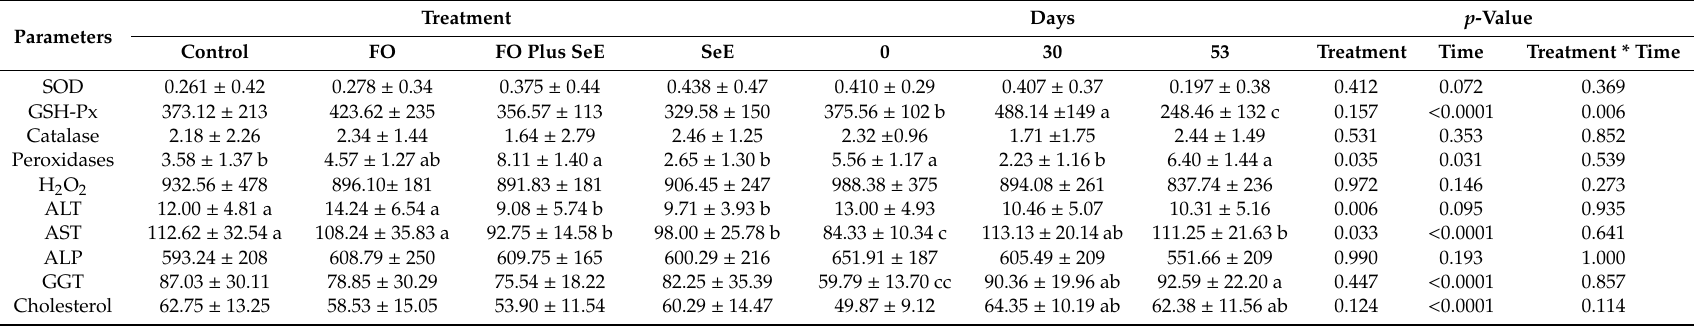
Table 4. Plasma and serum oxidative stress and blood parameters (means ± s.d.) of lambs fed a high-concentrate diet with di ff erent antioxidants. Parameters